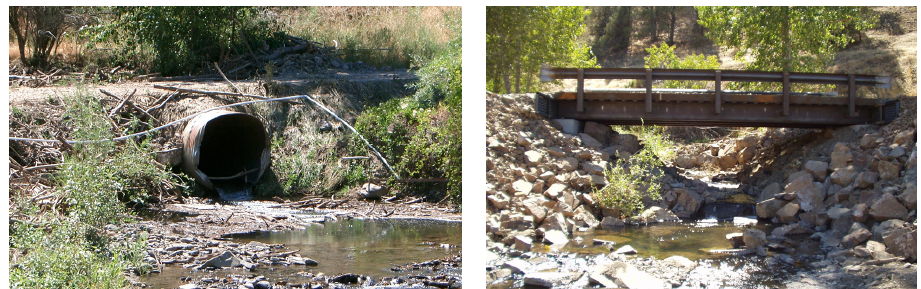
Figure 1. Original undersized culvert and subsequent bridge replacement.